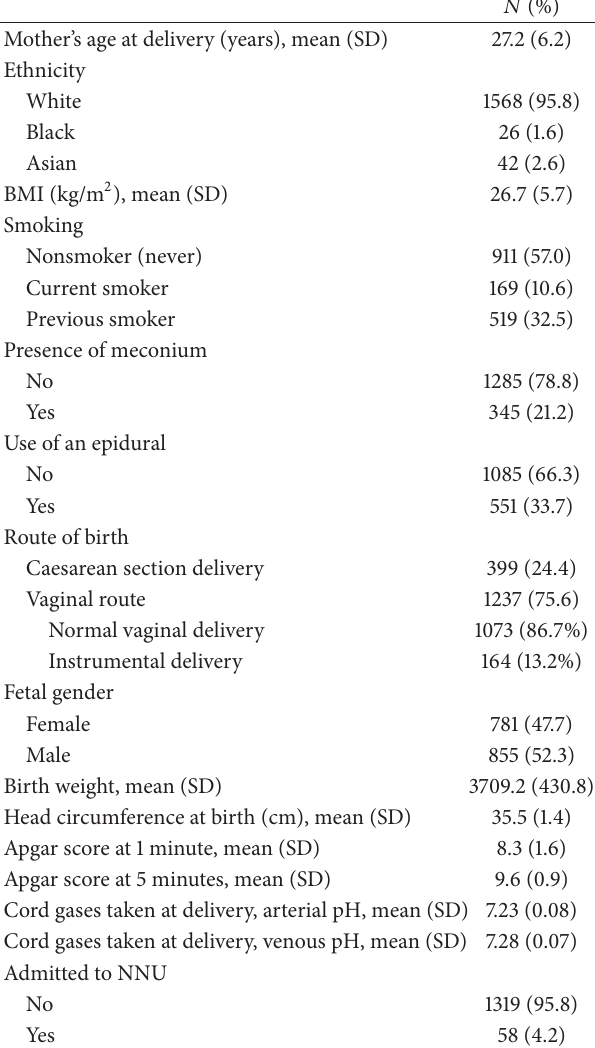
Table 1: Total sample characteristics ( 𝑛 = 1 , 636